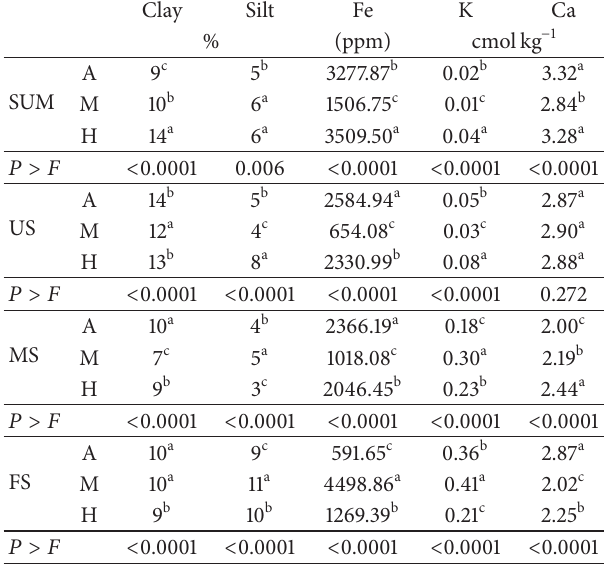
Table 3: Mean values of clay, silt, Fe, K, and Ca contents in soil at different topographic positions for different abundance of Imperata